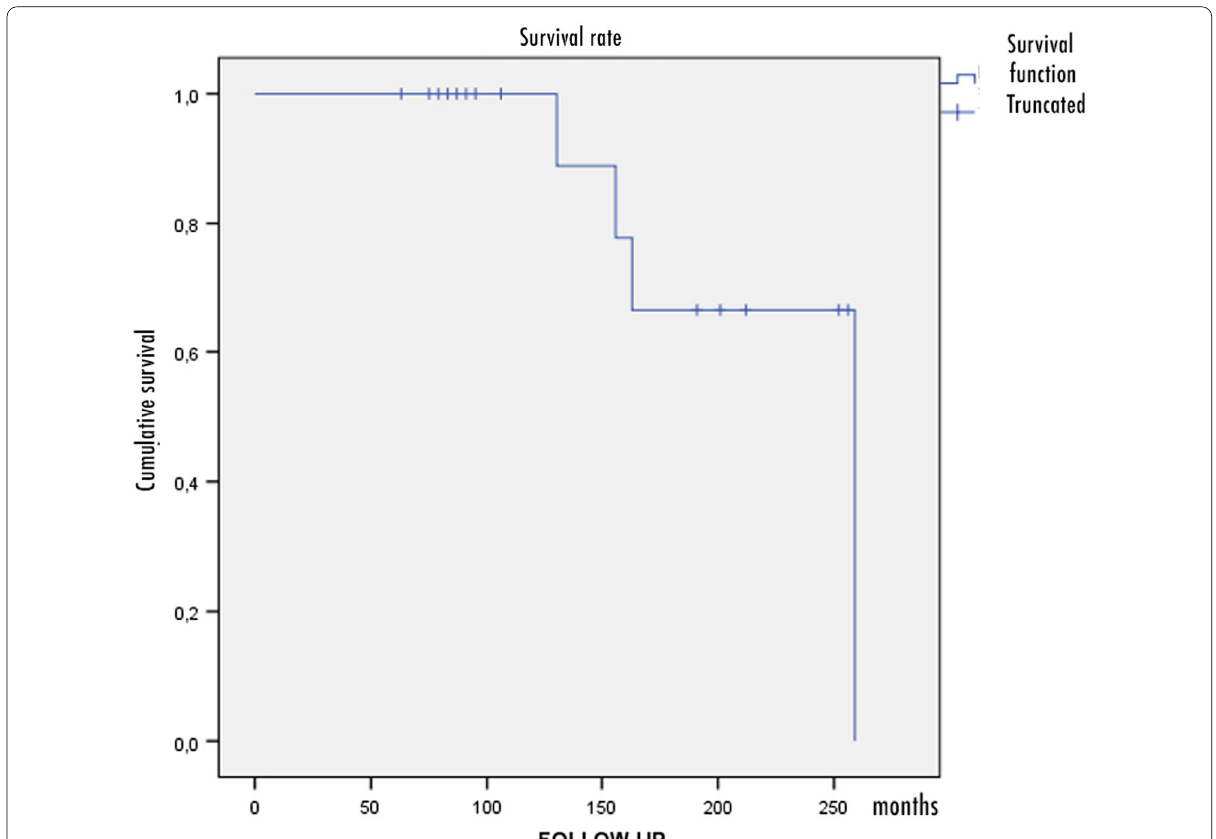
Fig. 3 Kaplan–Meier survival rate curve showing conversion to TKA during the follow-up period. Survival was 100% (95% CI [100%, 93.1%]; p < 0.01) at a follow-up of 10 years and 66.7% (95% CI [74.1%, 59.3%]; p < 0.01) at a follow-up of 15